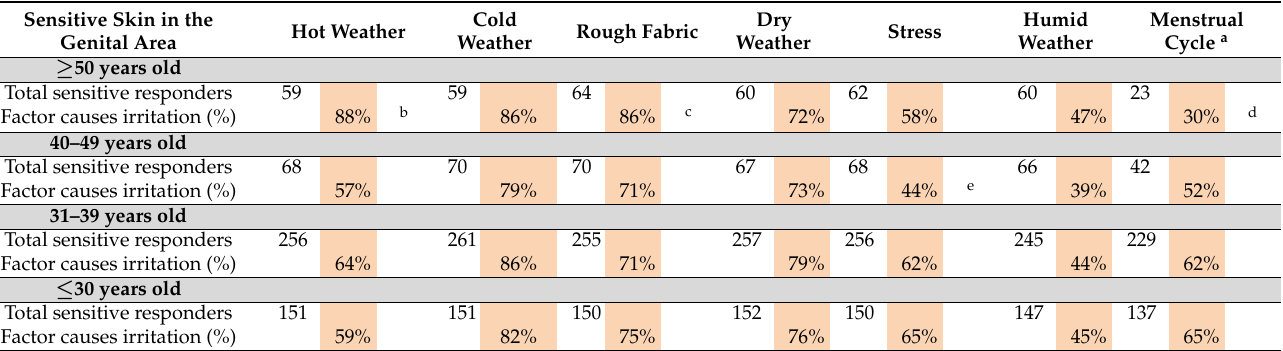
Table 4. Perceptions about irritation due to environmental factors for those claiming genital skin sensitivity.